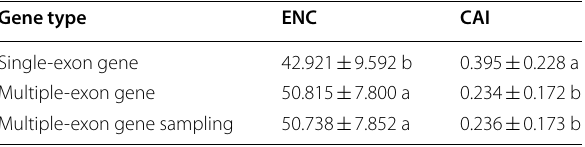
Data are reported as means SD ± Within a column, mean values followed by different letters indicate significant difference at the 0.05 level ( p <